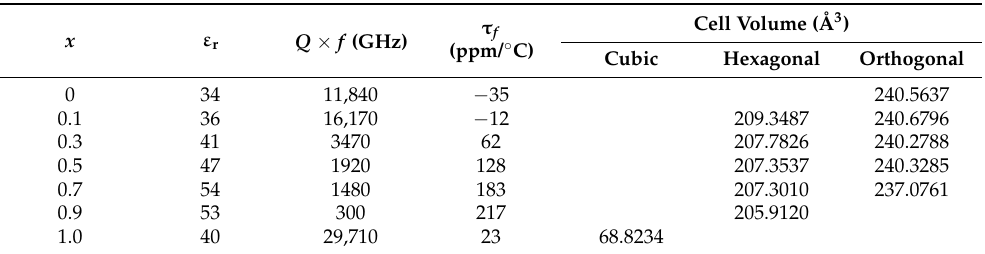
Table 2. Microwave dielectric properties and cell volumes for (Ca 1 − x Ba x )(Zn 1/3 Nb 2/3 )O 3 ceramics ( f = 5.4–6.7 GHz); data from Ref.